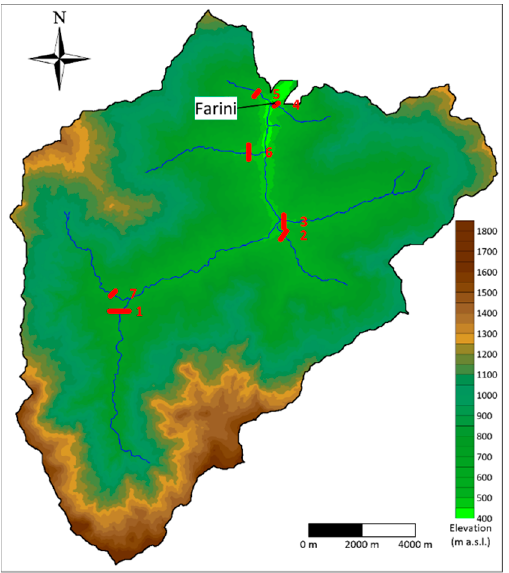
Figure 12. Bathymetry of the Nure watershed and investigated cross sections.